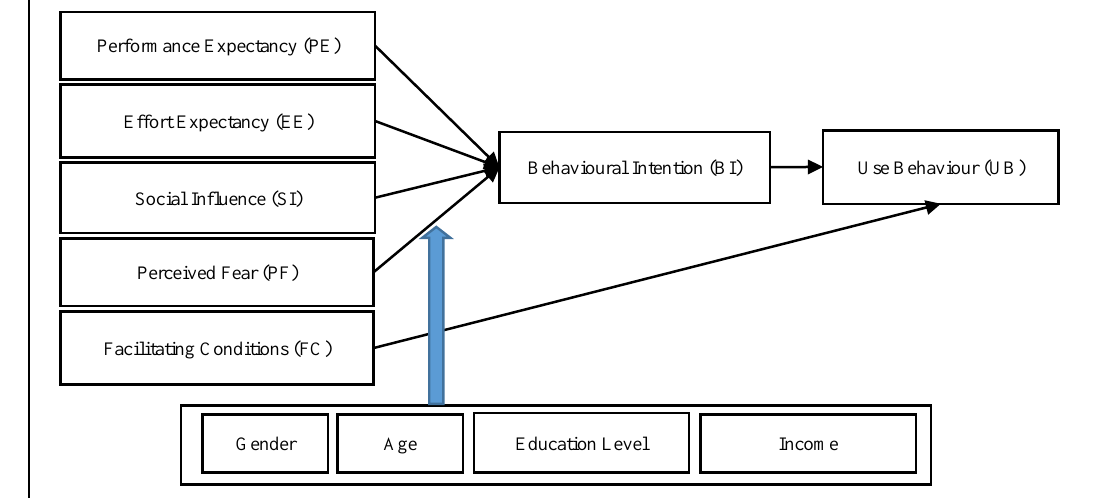
Figure 1. The study’s conceptual